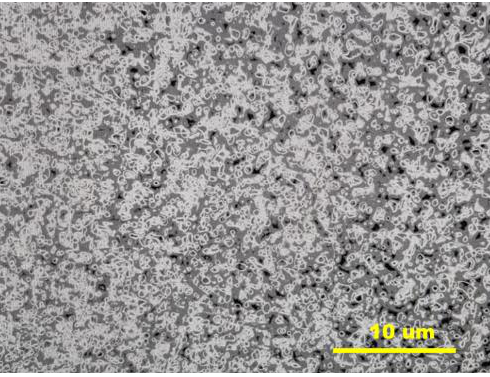
Figure 4. Micro-CT image (10 µm voxel size) of PU-NC4 sample.